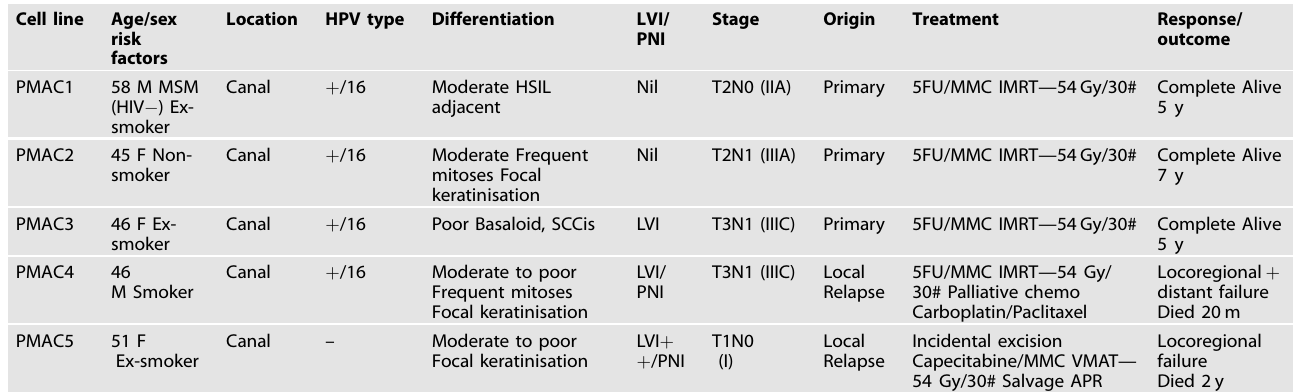
Table 1. Cell line origin: patient demographics, tumour characteristics, treatment and response. Cell